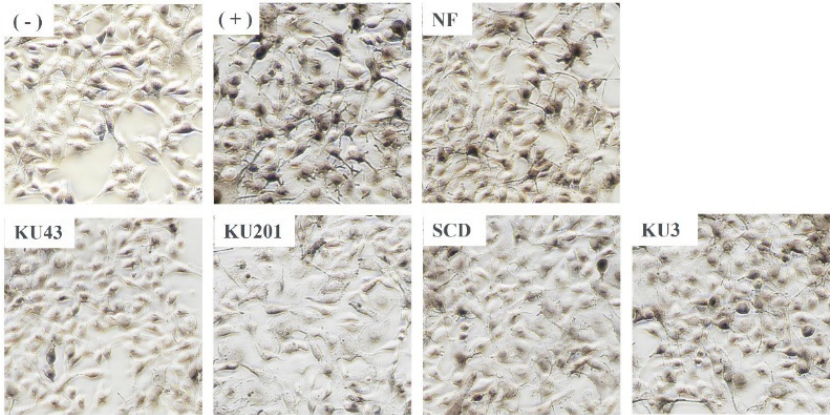
Figure 6. L-3,4-dihydroxyphenylalanine (L-DOPA) staining in B16F10 cells. ( − ): negative control without α -melanocyte-stimulating hormone ( α -MSH); (+): positive control with α -MSH; NF: non- fermented hydroponic ginseng (HG); KU43: HG fermented with B. subtilis KU43; KU201: HG fer- mented with B. subtilis KU201; SCD: HG fermented with B. polyfermenticus SCD; KU3: HG fermented with B. polyfermenticus